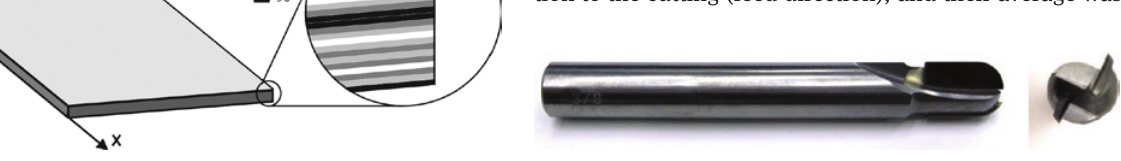
Figure 2: Layup of multidirectional CFRP. Figure 3: Two-flute PCD ball end